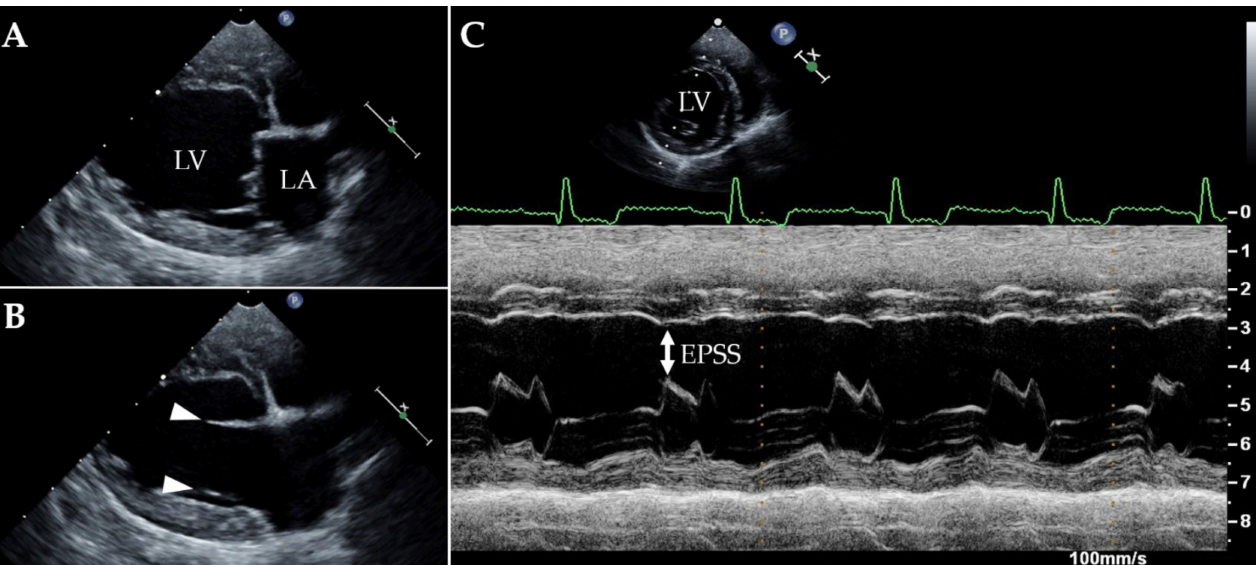
Figure 3. Two-dimensional echocardiographic findings obtained from a right parasternal long-axis four-chamber with open and closed mitral valve leaflets (( A ) and ( B ), respectively). Note that the left ventricle is characterized by eccentric hypertro- phy and a roundish appearance. Note also the lack of mitral valve abnormalities, as neither systolic prolapse nor valvular nodules can be identified (white arrowheads indicated leaflets during ventricular diastole). M-Mode echocardiographic findings obtained from a right parasternal short-axis view at the mitral valve level ( C ). Note the left ventricular systolic hypokinesia, expressed as a significantly reduced excursion of the left ventricular walls during systole and as a remarkable increase of the EPSS (white arrow). EPSS, mitral-valve E-point-to-septal-separation; LA, left atrium; LV, left ventricle; P: reference transducer mark; X over a white bar: focal point at the depth level of interest on the ultrasound image. Table 1. Selected echocardiographic findings measured at arrival (T0) and at first control (T1) in the dog from this report. Parameter T0 T1 Reference Intervals LA/Ao 1.2 1.15 <1.6 a LAD (mm)